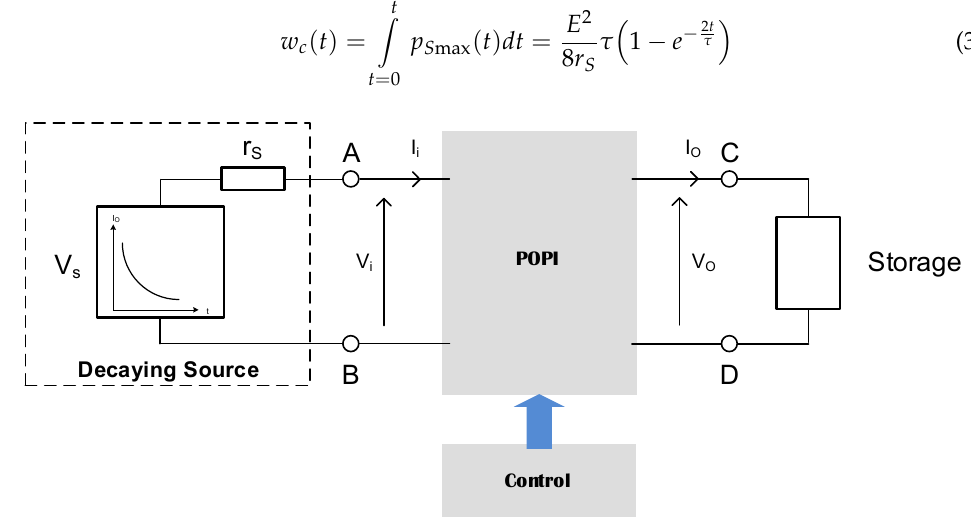
Figure 13. Decaying source matched to a general storage system by a POPI network.